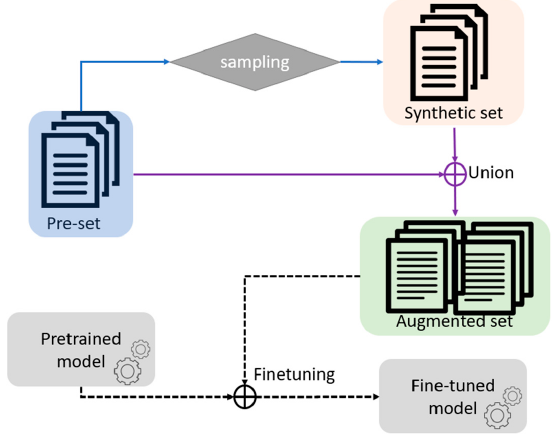
Figure 1. Prototype of the data augmentation process. To produce a fine-tuned model, we first used a pre-trained model and the pre-set (or set of premises) to learn the estimator for later constructing a synthetic set via a sampling process. The synthetic set was then united with the original dataset into an augmented set, which acted as the resource for fine-tuning the pre-trained model on a specific task.